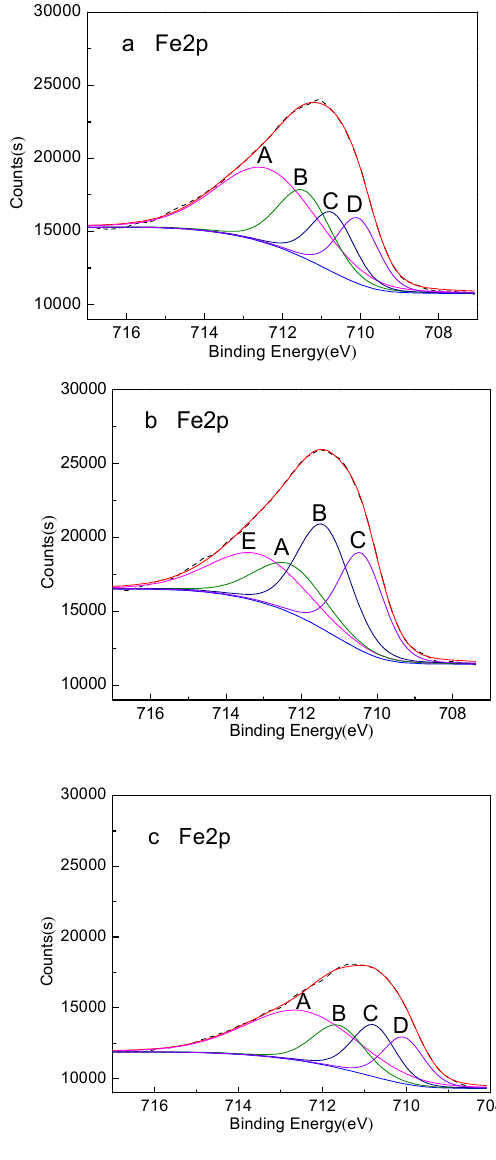
Figure 10. Fe2p spectra for the pyrrhotite surface treated: ( a ) without conditioning; ( b ) with conditioning under the natural atmosphere for 20 min; and ( c ) with conditioning under the nitrogen atmosphere for 20 min.